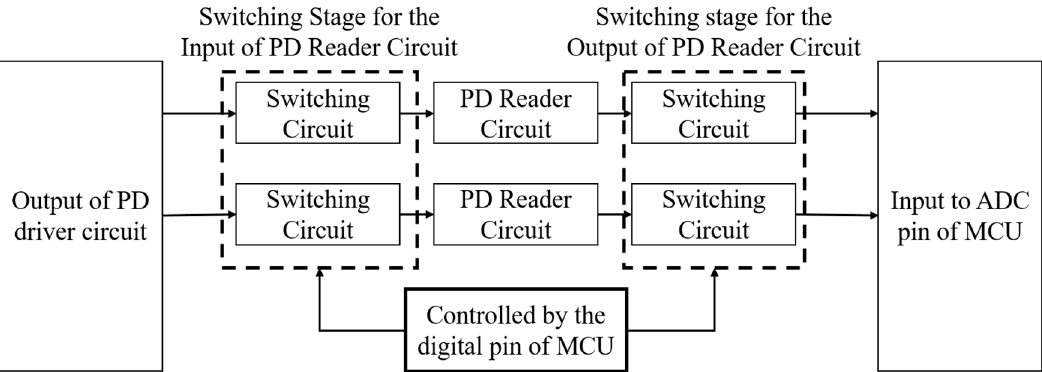
Figure 5. Proposed electronic circuit blocked diagram.